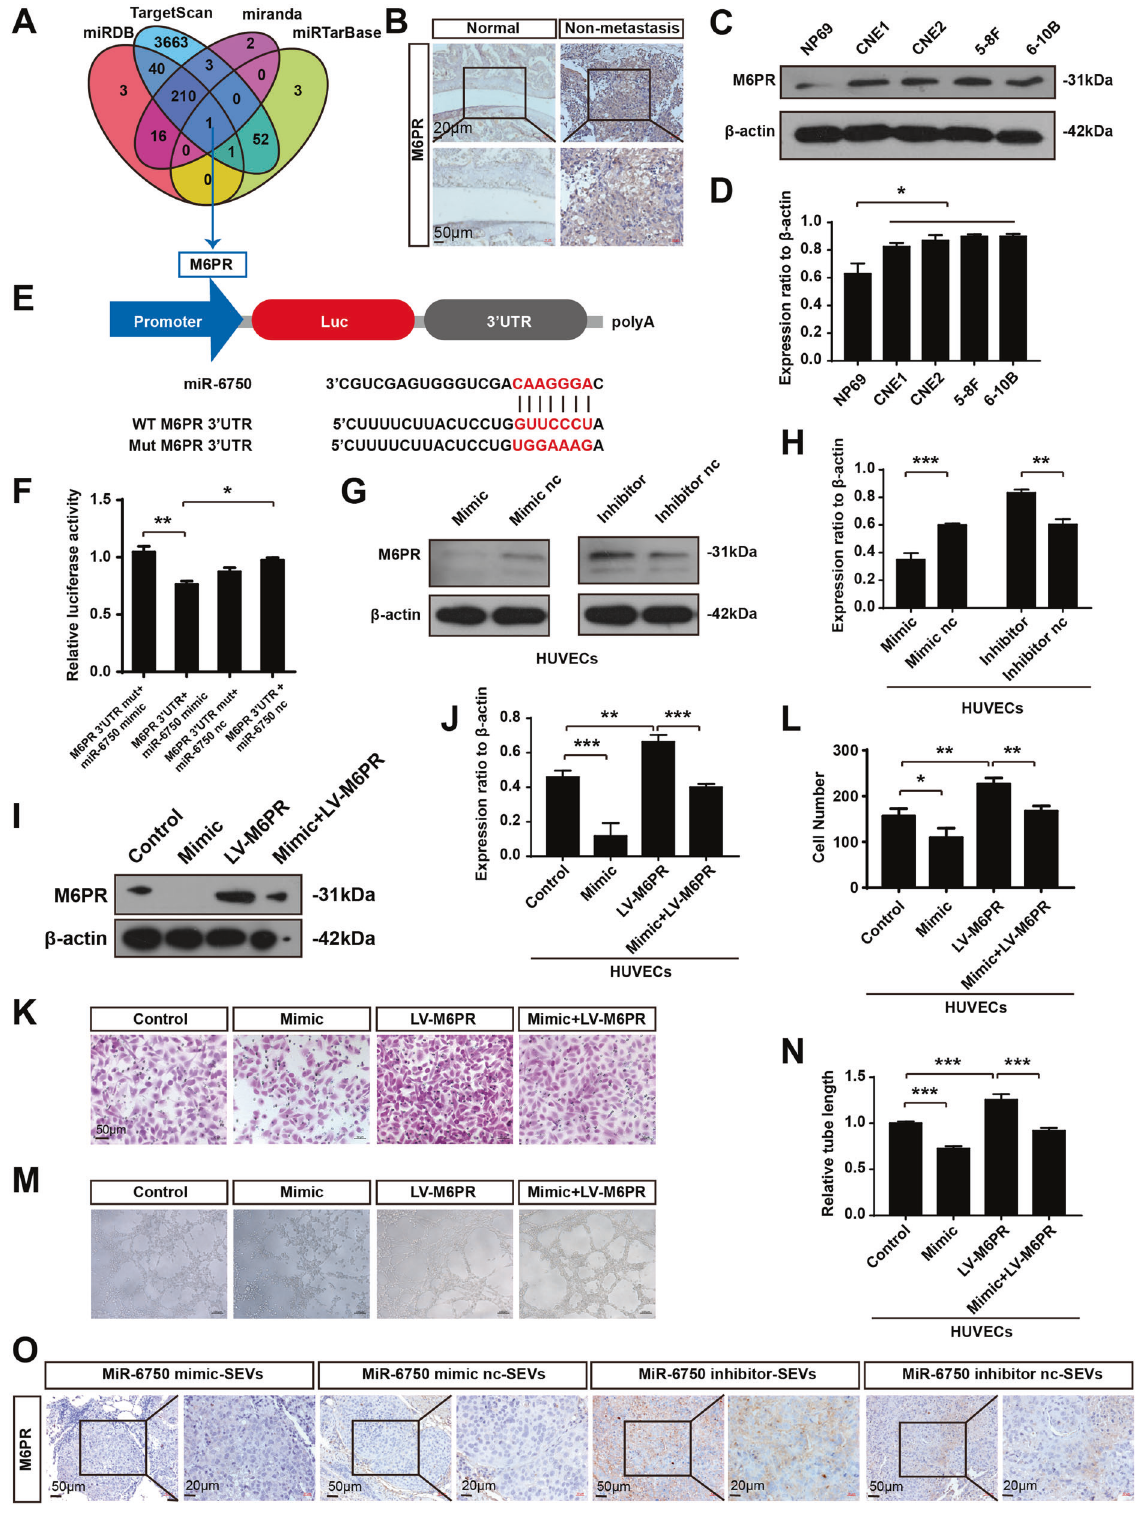
Fig. 7 MiR-6750 directly targets M6PR. A Venn diagram depicting showing predicted MIR-6750 targets. B Representative IHC images of M6PR in NPC tissues. C , D Levels of M6PR in NPC cells measured by western blot. Student ’ s t-test. E , F Overexpression of miR-6750 reduced M6PR-3 ′ -UTR luciferase activity in vitro but not mutated M6PR-3 ′ -UTR luciferase activity. Student ’ s t-test. G , H M6PR immunoblotting in HUVECs treated as indicated was analyzed. Student ’ s t-test. I , J M6PR immunoblotting in HUVECs treated as indicated was analyzed. One-way ANOVA. K , L Transwell migration assays were performed to measure cell migration. Student ’ s t-test. M , N Tube formation assays were performed using Matrigel. One-way ANOVA. O Representative IHC images of M6PR in mice metastatic lung tissues.